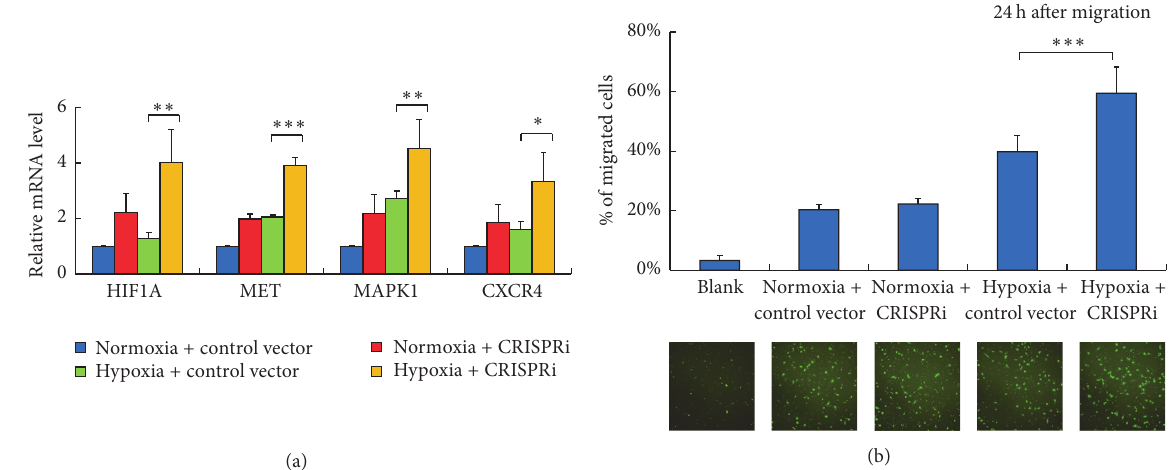
Figure 3: Inhibition of the miR-199a/214 cluster derepresses hypoxia-related targets and promotes NSC tumor tropism in vitro. (a) Relative expression levels of HIF1A, MET, MAPK1, and CXCR4 in NSCs are quantified by qPCR ( 𝑛 = 3 ). Error bars: SD. ∗ 𝑃 < 0.05 , ∗∗ 𝑃 < 0.01 , and ∗∗∗ 𝑃 < 0.001 . (b) In vitro migration of NSCs in Boyden chamber. Only DMEM is in lower chambers of the blank group. 4T1 cells are seeded in lower chambers of other groups as attractants. NSCs are transduced with baculovirus and stained with calcein-AM and seeded in the upper chamber. After 24 h, the labelled NSCs which migrated toward the lower chamber were evaluated ( 𝑛 = 6 ). Top: percentage of migrated NSCs. Bottom: fluorescence images showing the migration of NSCs toward the lower chambers. Error bars: SD. ∗∗∗ 𝑃 < 0.001 .